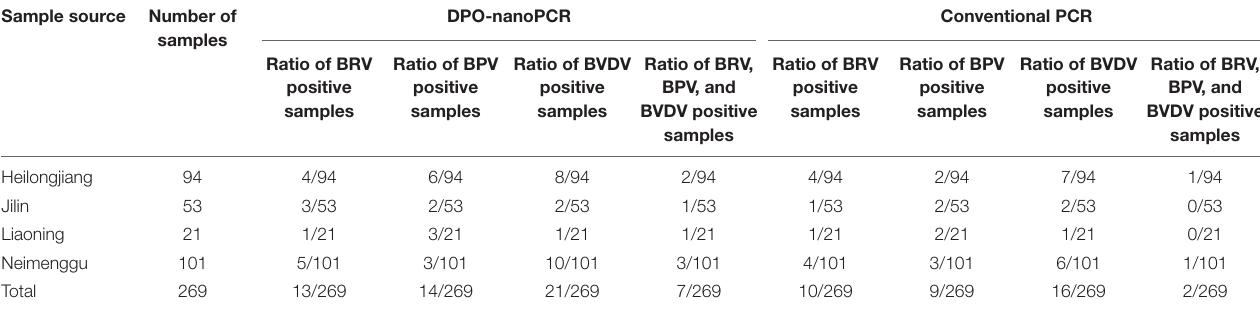
TABLE 3 | Detection of clinical samples by DPO-nanoPCR and conventional PCR. Sample source Number of samples